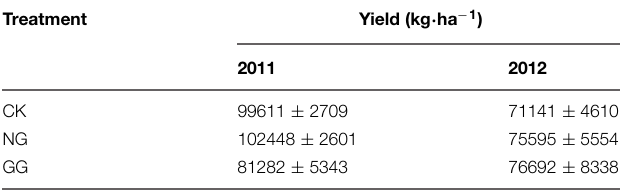
TABLE 1 | Eggplant yields of the three treatments in 2011 and 2012.